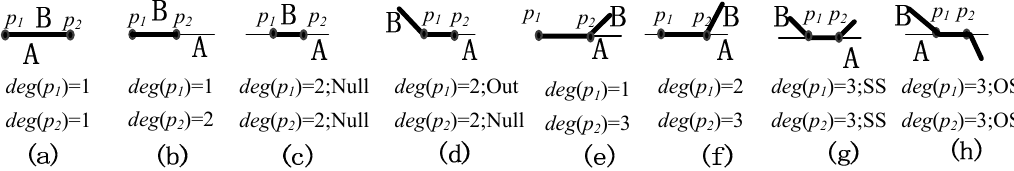
Figure 10. Eight types of possible and asymmetric intersection-lines between lines. ( a ) Case of degree-pair (1, 1); ( b ) Case of degree-pair (1, 2); ( c ) Case of degree-pair (2, 2) with Null adjacent point kind; ( d ) Case of degree-pair (2, 2) with Null and Out adjacent point kind; ( e ) Case of degree-pair (1, 3); ( f ) Case of degree-pair (2, 3); ( g ) Case of degree-pair (3, 3) with SS comprehensive adjacent point kind; ( h ) Case of degree-pair (3, 3) with OS comprehensive adjacent point kind.